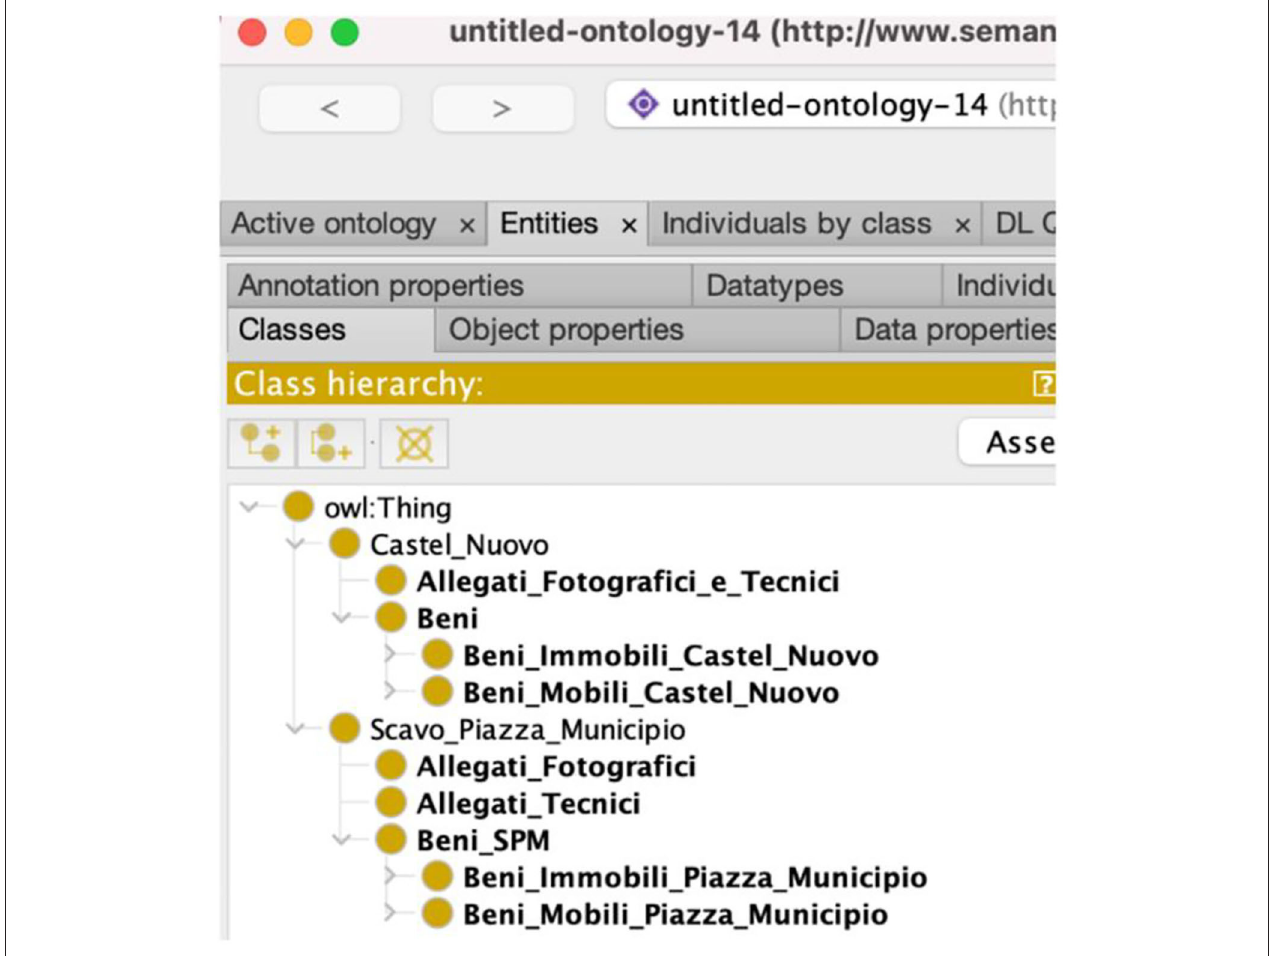
FIGURE 3 | A detail of the PAUN ontology showing the superclasses “Castel Nuovo” and “Scavo Piazza Municipio” which reflect the two domains corresponding to the main areas of the Urban Archaeological Park of